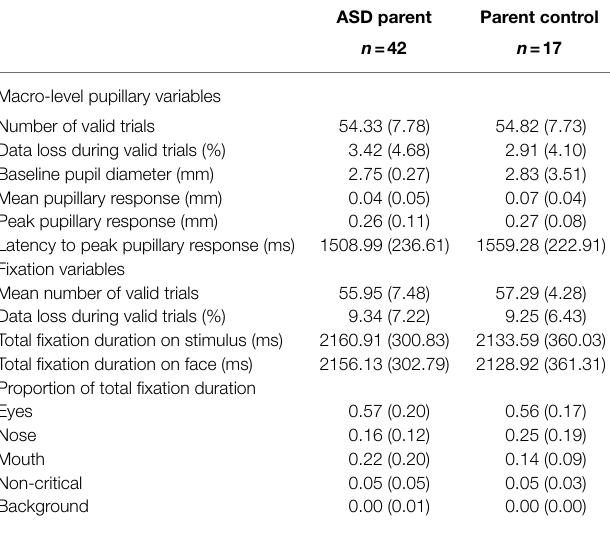
TABLE 2 | Macro-level pupillary responses and fixation variables (means and standard